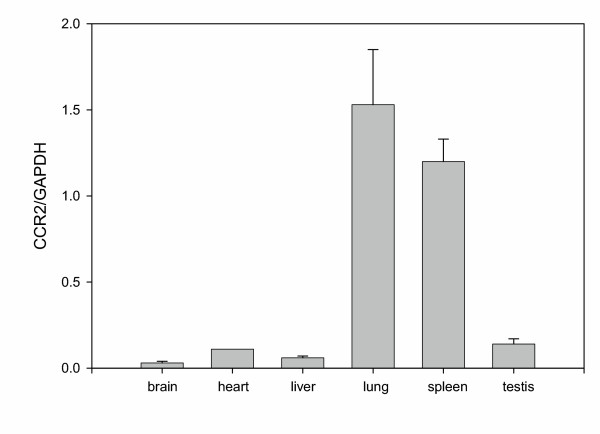
Tissue distribution of rabbit CCR2. The mRNA levels from rabbit tissues were quantitated by Taqman technique as described under "Materials and Methods". CCR2 mRNA levels are expressed as the ratio of CCR2 and GAPDH. Error bars represent the mean ± standard deviation of quadruplicate values.